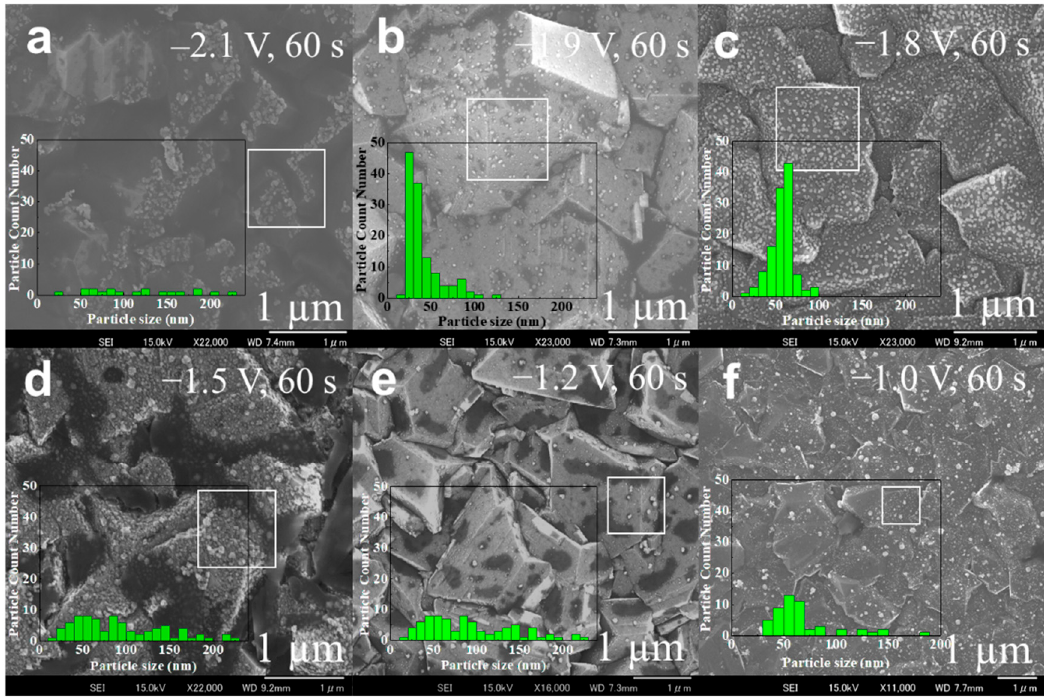
Figure 1. ( a – f ) Scanning electron microscopy (SEM) images show the potential-dependent difference in the density of gold nanoparticles (AuNPs) synthesized on boron-doped diamond (BDD) films. The inset in each image shows the histogram of the particle size corresponding to the area enclosed by the white box (1 µm²). The particle size was analyzed using ImageJ.